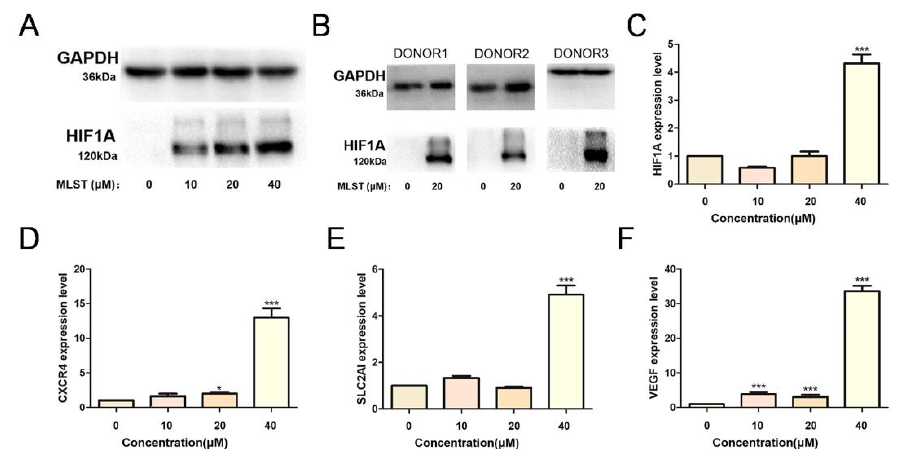
Figure 7. Molidustat increased HIF1A expression and induced hypoxia-inducible factor (HIF) pathway activation. ( A ) MEC-1 cells were treated with 0, 10, 20, or 40 µ M molidustat. Western blotting results showed that molidustat stabilized HIF1 α protein expression in MEC-1 cells in a concentration-dependent manner. ( B ) Primary cells from three CLL patients were treated with 0 or 20 µ M molidustat for 48 h. Western blotting results showed that HIF1 α protein was barely detectable in cells treated with 0 µ M molidustat but was substantially increased after treatment with 20 µ M molidustat. ( C – F ) MEC-1 cells were treated with 0, 10, 20, or 40 µ M molidustat, and the expression of HIF1A and its downstream genes was determined using qPCR. The results showed that molidustat promoted the transcription of HIF1A and its downstream genes (* means p ≤ 0.05, *** means p ≤ 0.001).